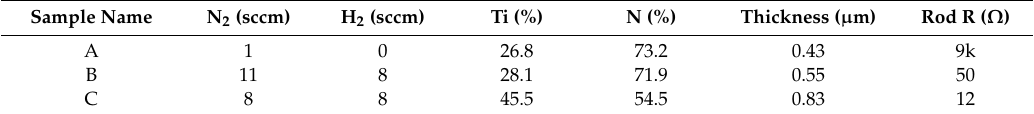
Table 1. Gas flows, Ti / N ratios, and rod resistances of Samples A, B, and